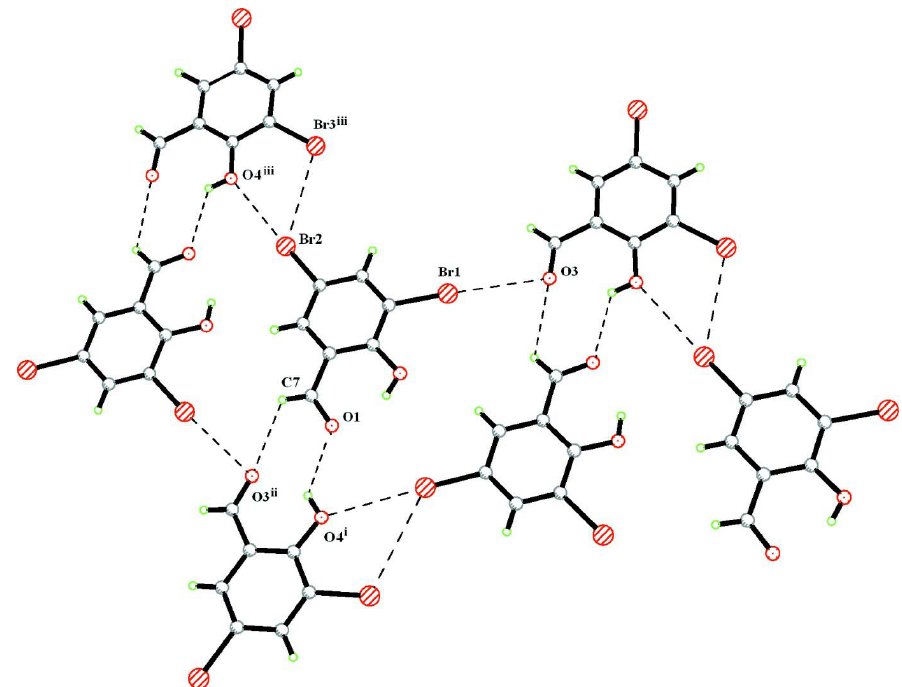
A perspective view of the intralayer intermolecular hydrogen-bond contacts among molecules in the title compound. Hydrogen bonds and Br–Br interactions are shown as dashed lines. [Symmetry codes: (i) - x + 1, y + 1/2, - z + 1/2; (ii) - x + 1,-1/2 + y , 1/2 - z ; (iii) x , -1 + y , z